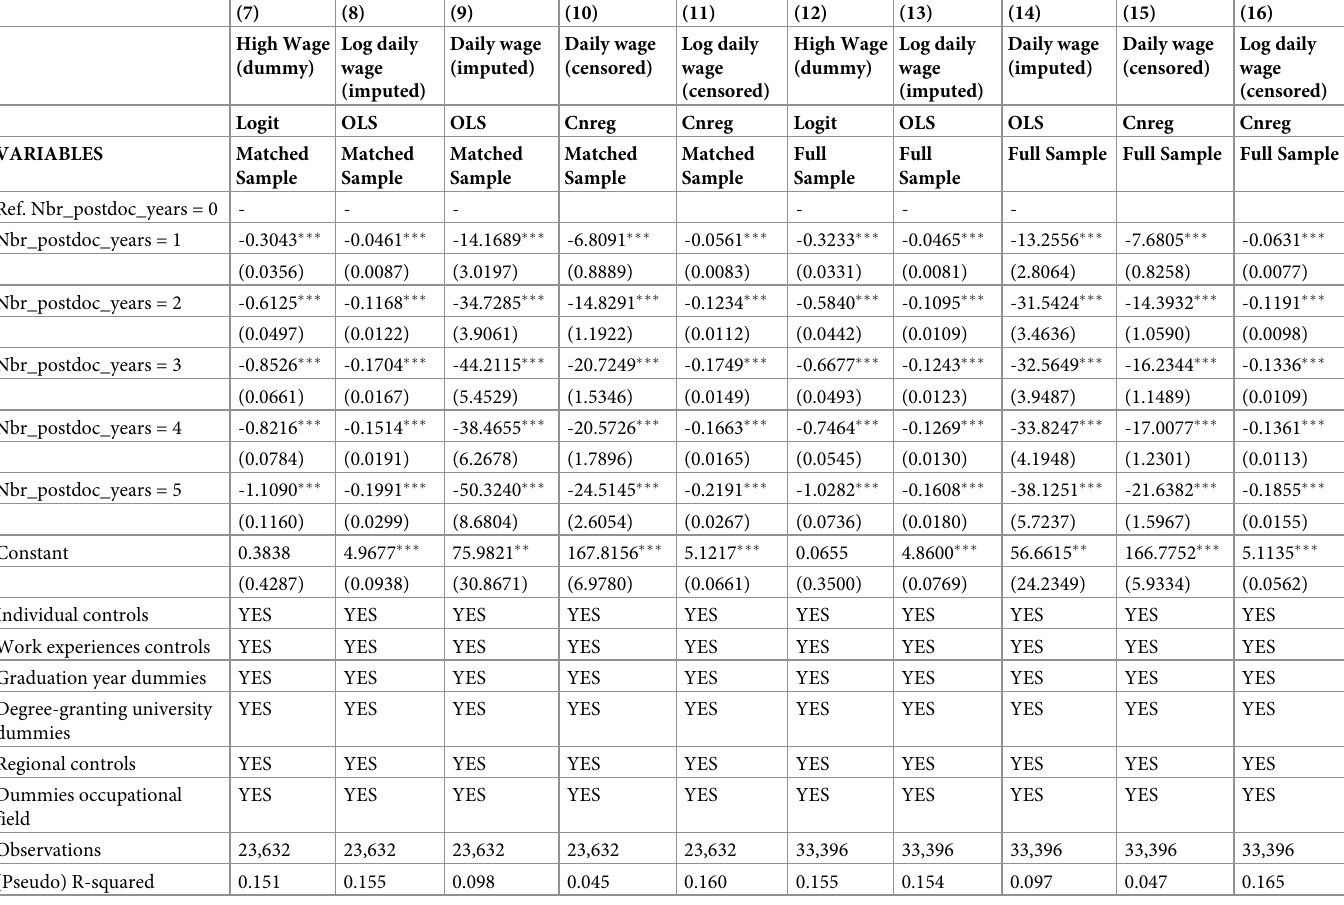
Table 3. Robustness analysis for regression of doctorate recipients’ income 5 years after